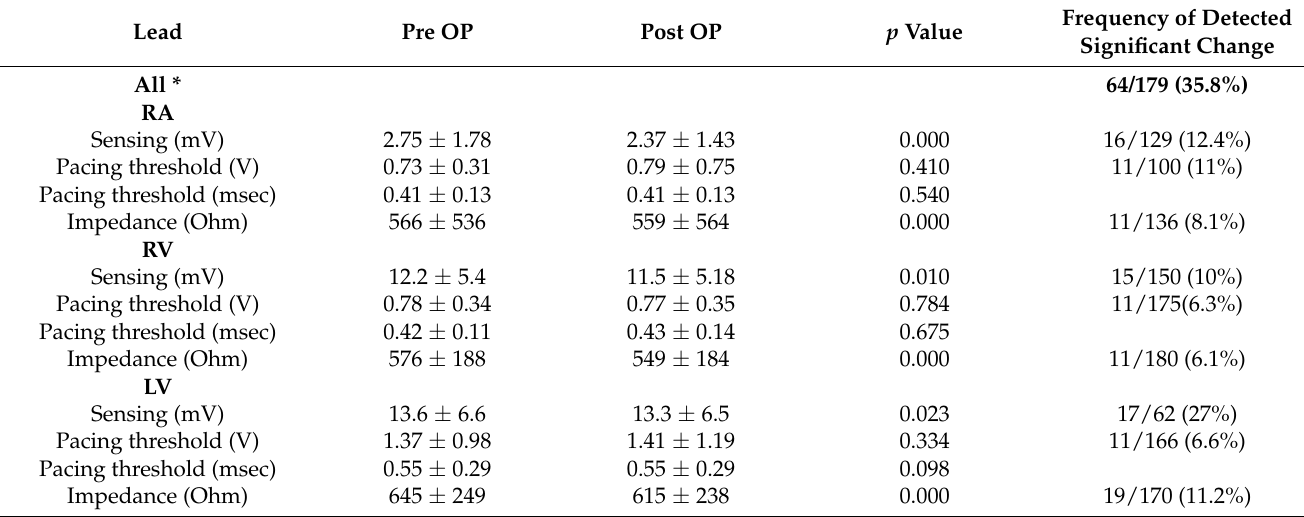
Table 10. Specific CRT lead parameters in pre- and postoperative